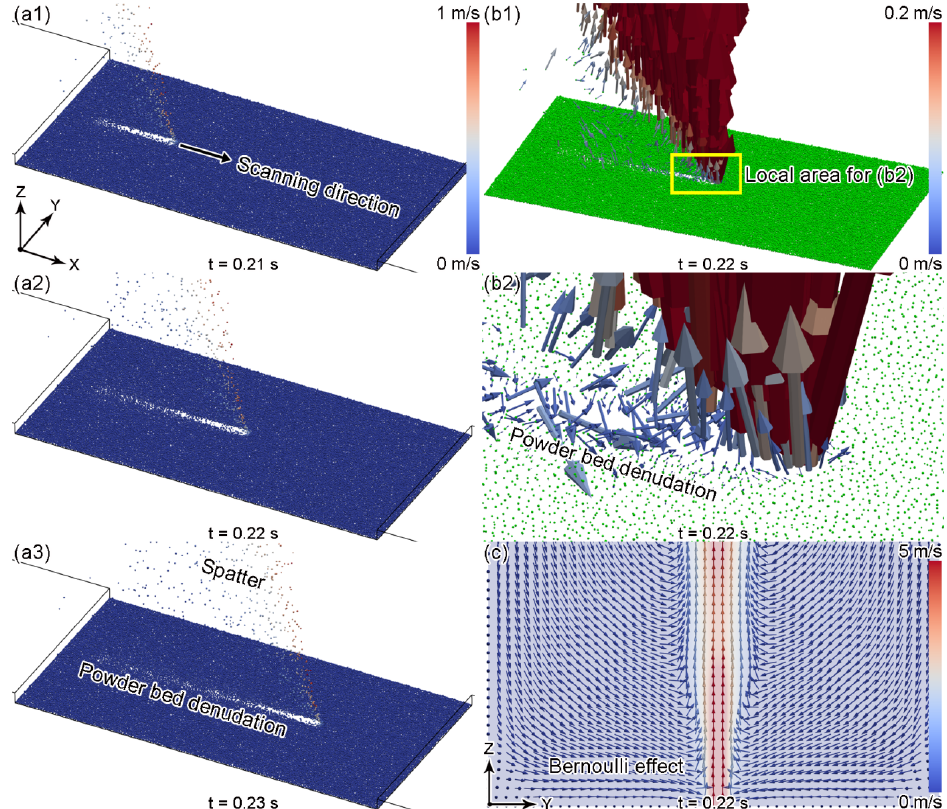
Figure 4. Particle motion and gas-phase flow in Scheme B: ( a1 – a3 ) spatter and powder bed denudation at different moments (particle colors represent particle motion speeds); ( b1 , b2 ) particle velocity distribution in the powder bed and local area at t = 0.22 s (arrows represent particle velocities; in b2 , particles are scaled down to 0.2 times the original size to visualize particle velocities); ( c ) gas-phase velocity distribution in the X-direction mid-section at t = 0.22 s (arrow directions represent the gas-phase flow directions, background color represents the gas-phase flow speed).